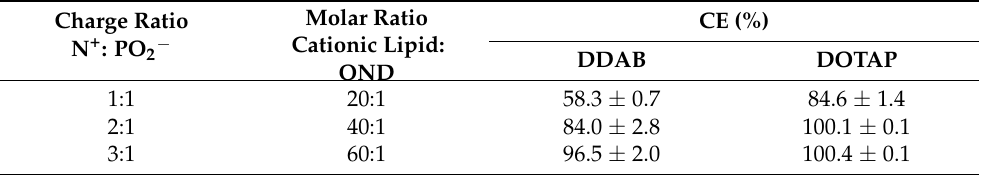
Table 3. Complexation efficiency (CE, %) of OND with a cationic lipid (DDAB or DOTAP) using the lipid (N+) and a nucleotide phosphate group in the backbone of 20-mer OND (PO 2 − ) were tested. Charge